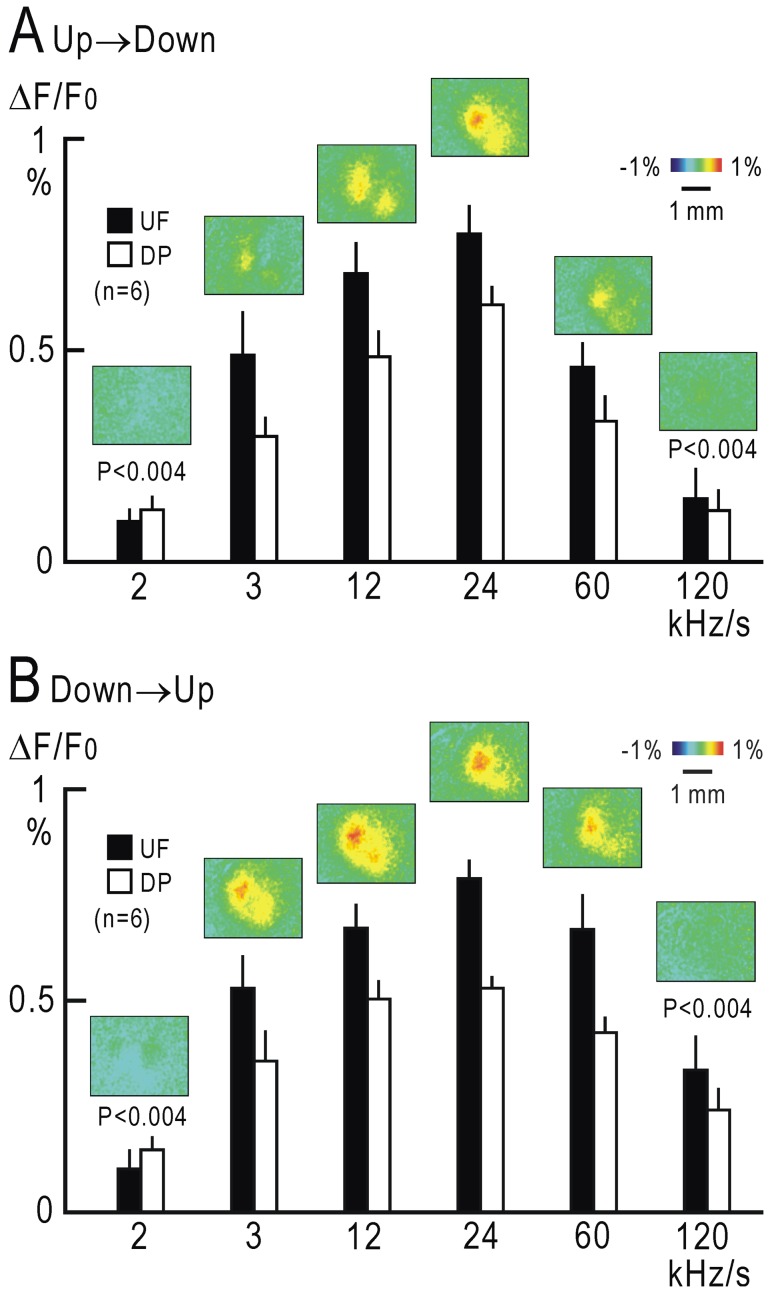
FM sweep speeds and cortical responses in UF and DP.(A) Response amplitudes to direction reversal of FM sweeps at a speed between 2 and 120 kHz/s from upward to downward in UF and DP of 6 mice. Insets show image examples. At a speed of 2 or 120 kHz/s, response amplitudes in UF and DP were significantly smaller than the corresponding values obtained at 24 kHz/s (P<0.004, respectively). (B) Response amplitudes to FM direction reversal between 2 and 120 kHz/s from downward to upward in UF and DP of the same 6 mice. At a speed of 2 or 120 kHz/s, response amplitudes in UF and DP were significantly smaller than the corresponding values obtained at 24 kHz/s (P<0.004, respectively).